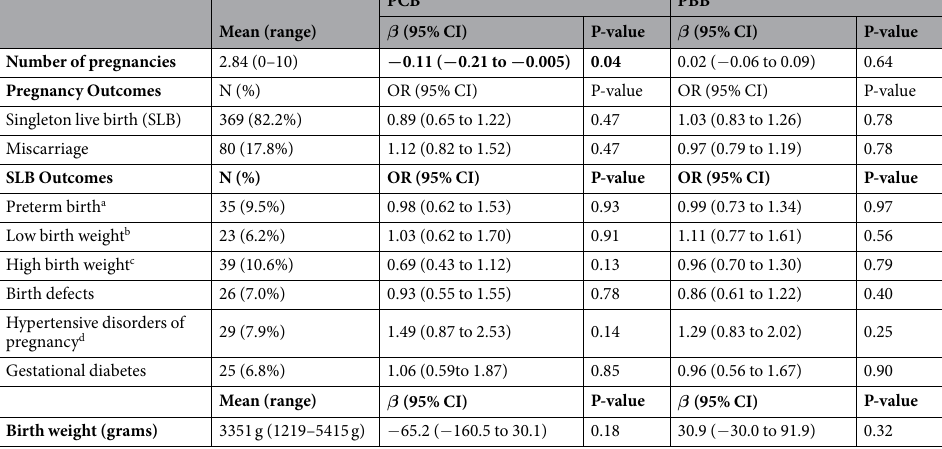
Table 4. Associations between exposures and pregnancy outcomes. Adjusted for age (current age & age at pregnancy), BMI, and total lipid levels. Total PCB levels adjusted for total PBB and total PBB levels adjusted for total PCB. OR = odds ratio. CI = confidence interval. Bold indicates statistically significant values with p-value of < 0.05. a < 37 weeks gestational age. b Self-reported birth weight < 2500 g. c Self-reported birth weight > 4000 g. d Gestational hypertension, preeclampsia, or